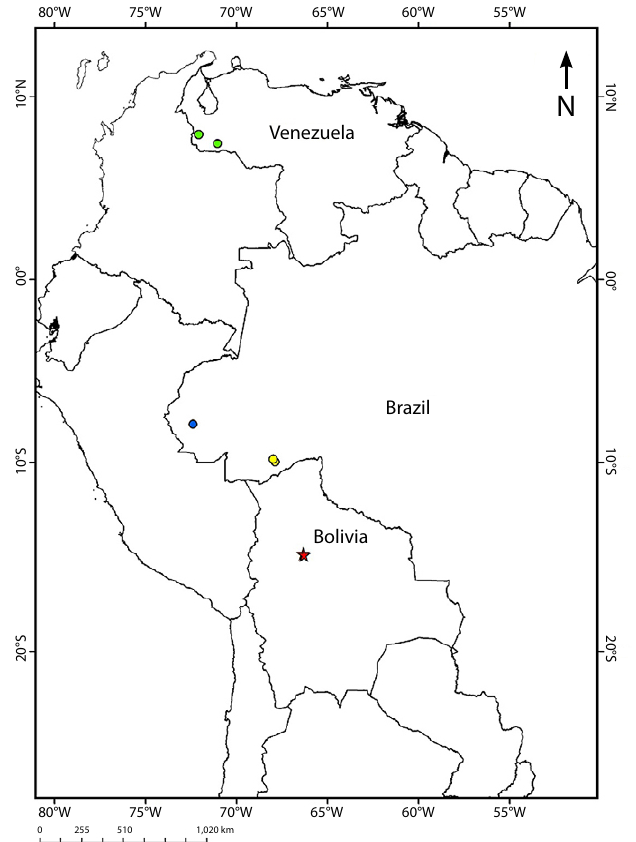
Figure 2. Distribution of known Erythrolamprus dorsocorallinus specimens (green circle: Esqueda et al. 2005; blue circle: Bernarde et al. 2011; yellow circles: Araújo et al. 2012) including new records from Bolivia presented in this study (red star).